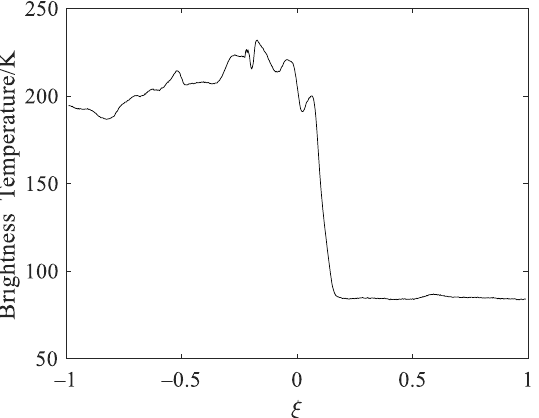
Figure 6. The original brightness temperature distribution of the